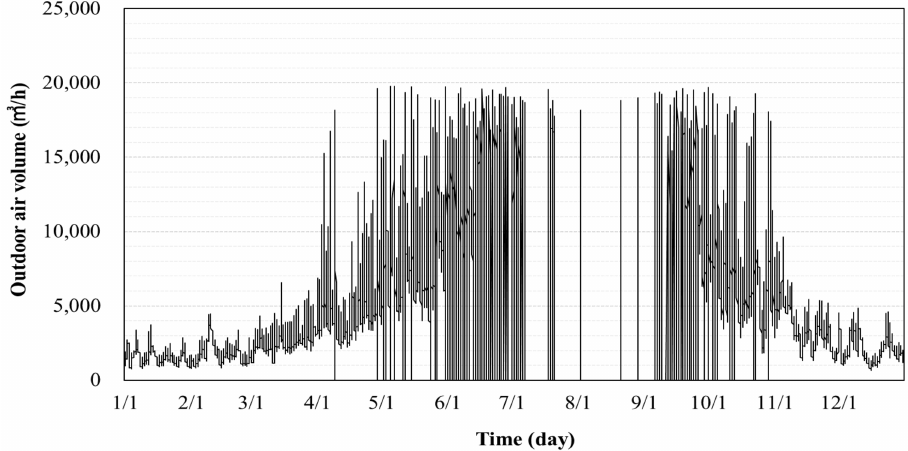
Figure 7. Annual variation of outdoor air volume with fan used for cooling.